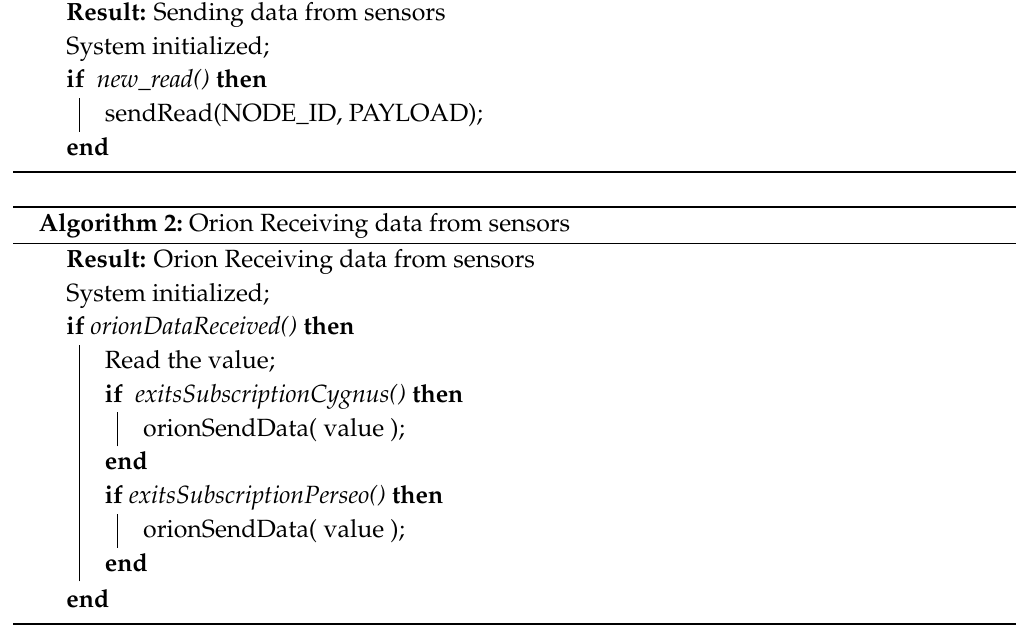
Algorithm 2: Orion Receiving data from sensors Result: Orion Receiving data from